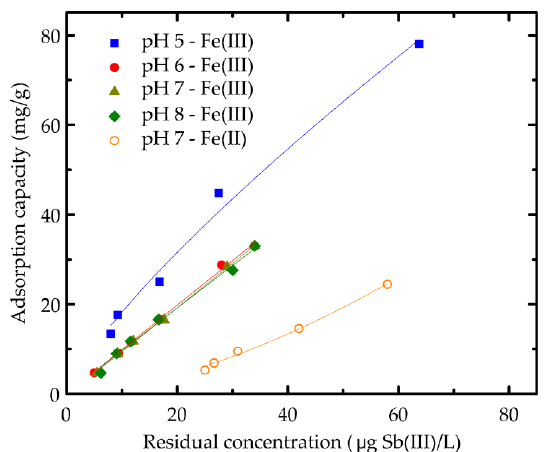
Figure 2. Fitting of Sb(III) adsorption (Freundlich model) onto FeOOH precipitates by using coagulation/precipitation with Fe(III) or Fe(II) salts at various water pH values; experimental conditions: T = 22 ± 1 °C, initial antimony concentration 100 μg Sb(III)/L, ir on dose range 1 – 10 mg/L. The better affinity of Sb(III) with the produced Fe(III) precipitate (FeOOH) at pH 5 is also